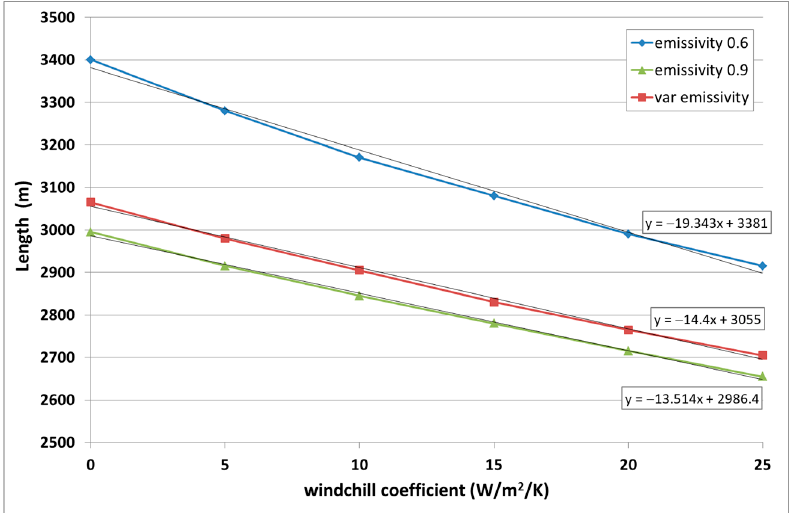
Figure 2. Trend of the maximum lengths of the lava flows simulated on a 20-degrees inclined plane using different windchill coefficients (from 0 to 25). Results were also obtained using a constant emissivity of 0.6 and 0.9 and a variable emissivity. The three downward trends were approximated by linear functions with slopes of about − 14 (for 0.9 and variable emissivity) and − 19 (for 0.6 emissivity).